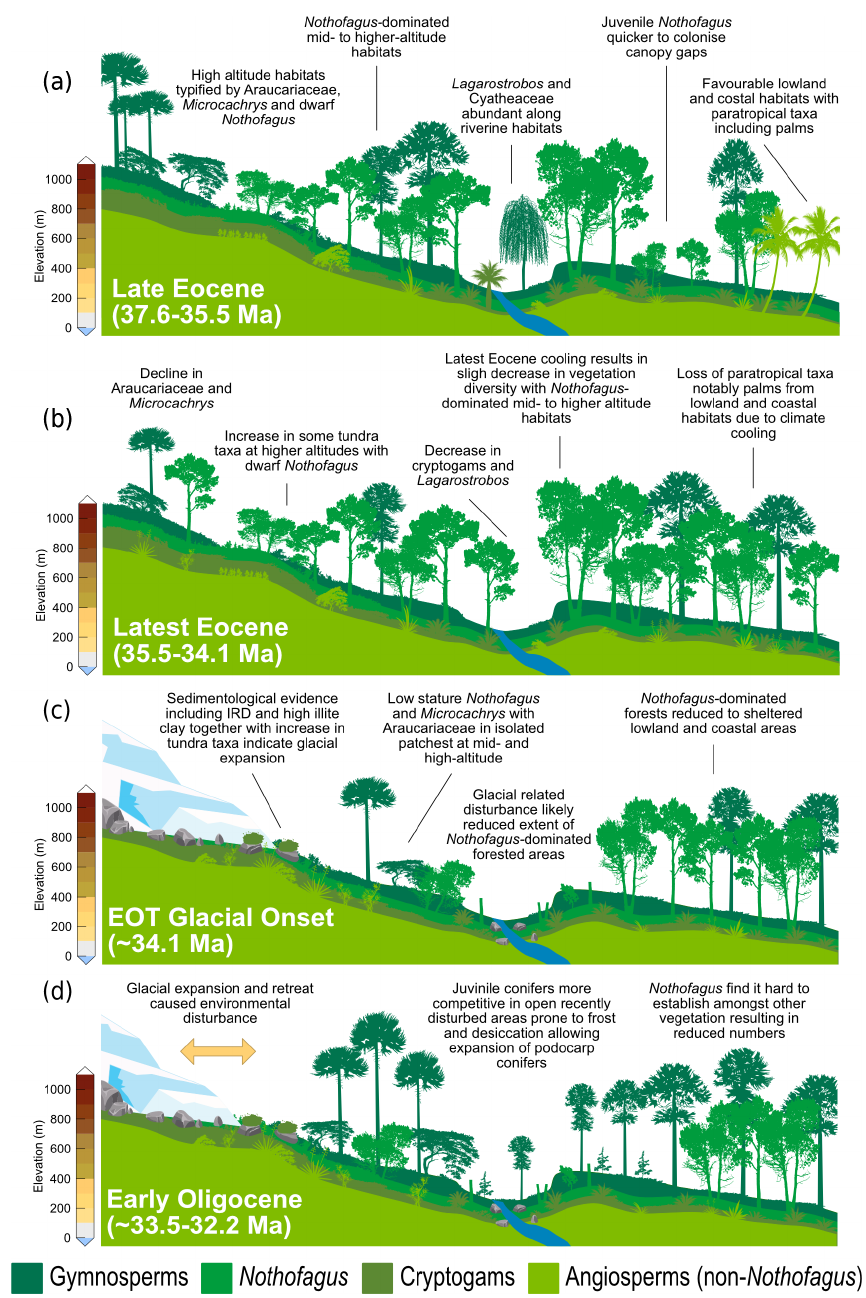
Figure 6. Schematic representation of vegetation from Site 696, illustrating the response of key taxonomic group to climate and environ- mental change through key intervals during the late Eocene and early Oligocene. (a) Late Eocene vegetation ( ∼ 37 . 6–35.5Ma): during the deposition of Zone Ia vegetation was dominated by Nothofagus with secondary podocarps and an understorey of cryptogams and minor angiosperms. Sporomorph-based climate estimates and the presence of thermophilic taxa indicate conditions were relatively warm com- pared to the rest of the section. (b) Latest Eocene after late Eocene climate cooling ( ∼ 35 . 5–34.1Ma): vegetation remained similar to that of the late Eocene and was still dominated by Nothofagus , but climate cooling by around 2 ◦ C resulted in loss of thermophilic taxa and slight decrease in taxon diversity. (c) EOT vegetation during glacial onset ( ∼ 34 . 1Ma): environmental disturbance caused by ice expansion and retreat resulted in the reduction in Nothofagus -dominated forested areas and increase in tundra-like vegetation. (d) Early Oligocene ( ∼ 33 . 5–32.2Ma): during glacial retreat and the development of milder climates disturbance and reduction in Nothofagus -dominated forests facilitated the expansion of more competitive Podocarpaceae and pioneer cryptogam